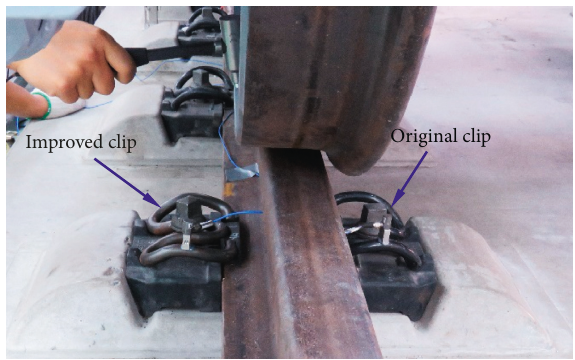
Figure 20: Frequency response test of the fastening clip before and after